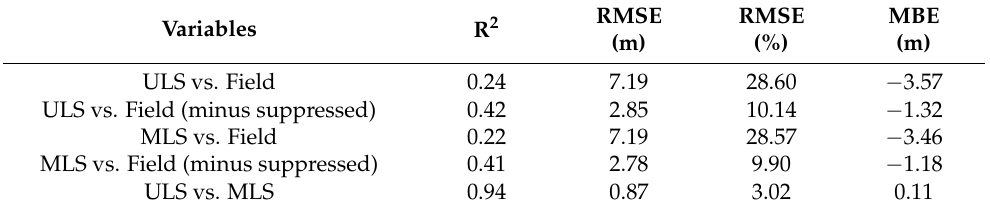
Table 2. Accuracy comparisons between point cloud-derived height and field-measured